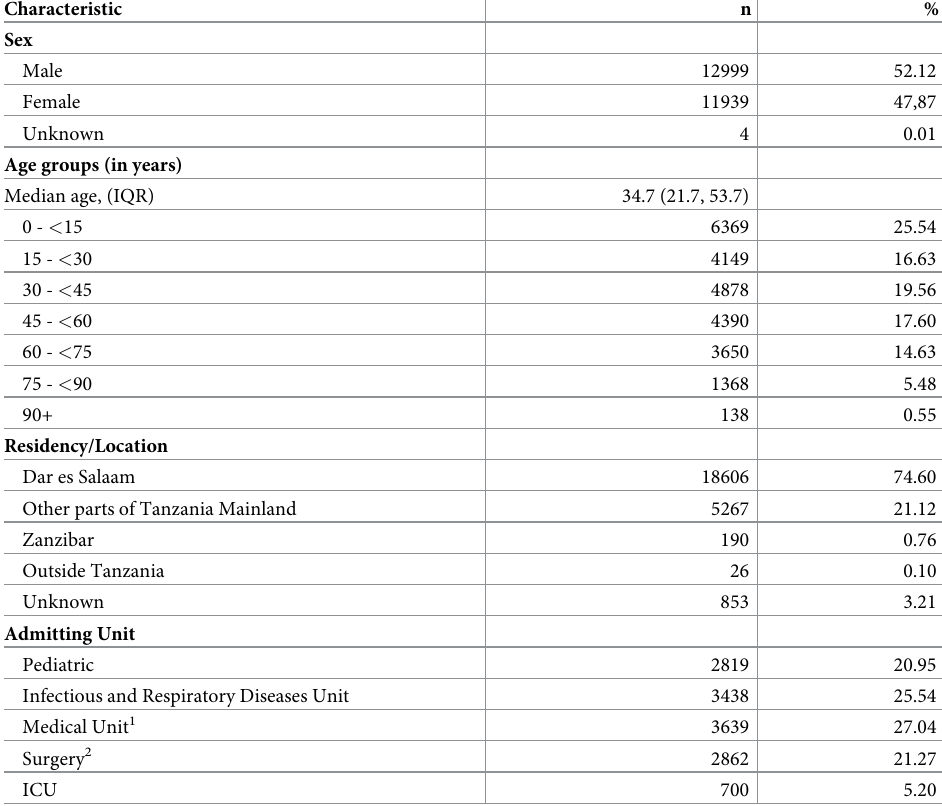
Table 1. Characteristics of patients with respiratory conditions at MNH EMD 2020–2021.